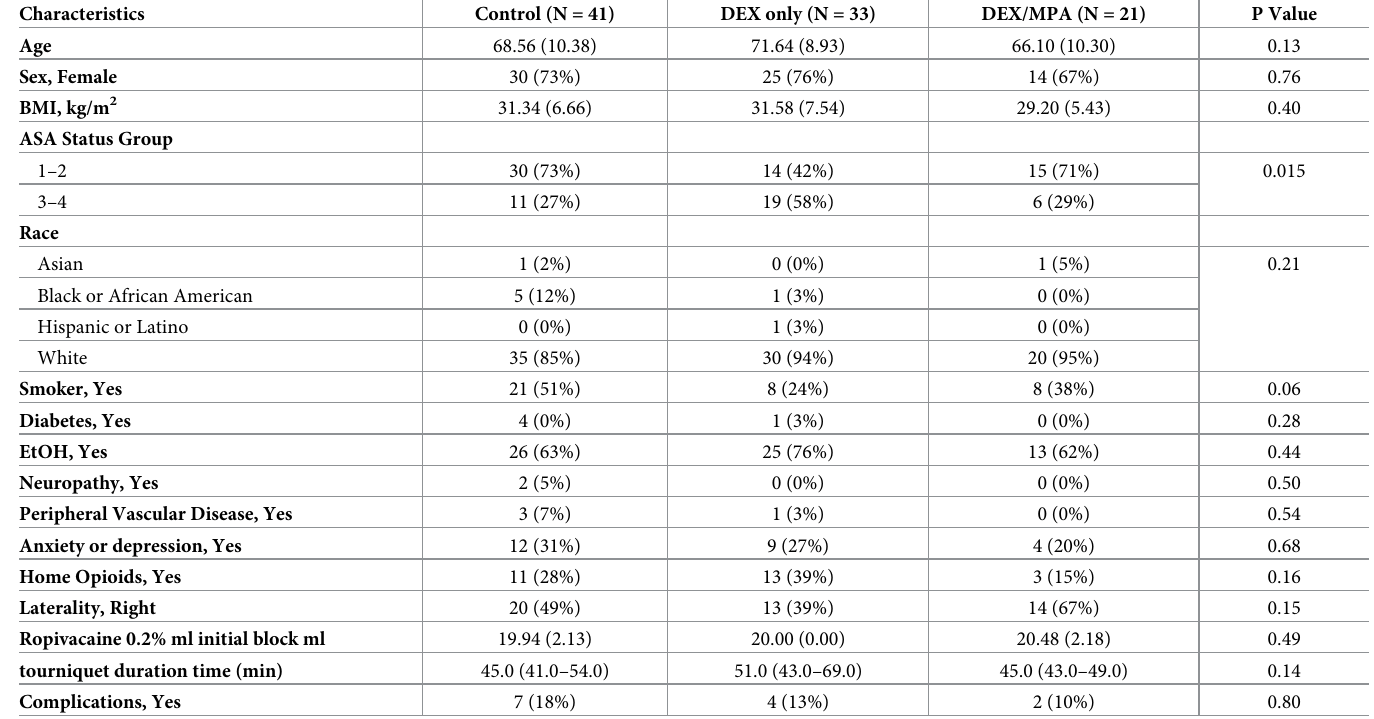
Fig 1. STROBE flowchart of screened and excluded patients. https://doi.org/10.1371/journal.pone.0261949.g001 DEX/MPA groups on POD 1 through POD 3 (Table 2). There was no significant difference in VAS pain scores between control vs DEX group, or control vs DEX/MPA group, or DEX vs DEX/MPA group on POD 1 through POD 3 at rest defined as right before physical therapy and with activity defined as during physical therapy (Table 2, Fig 3). Table 1. Demographics, baseline and perioperative